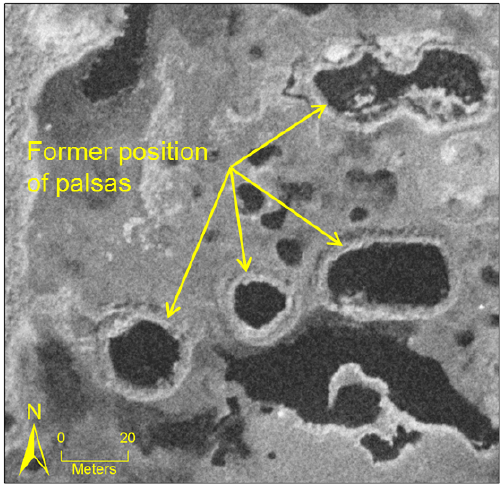
Figure 12. Examples of thermokarst lakes encircled by rim ridges in an image from 1958 of the palsa region 4 in